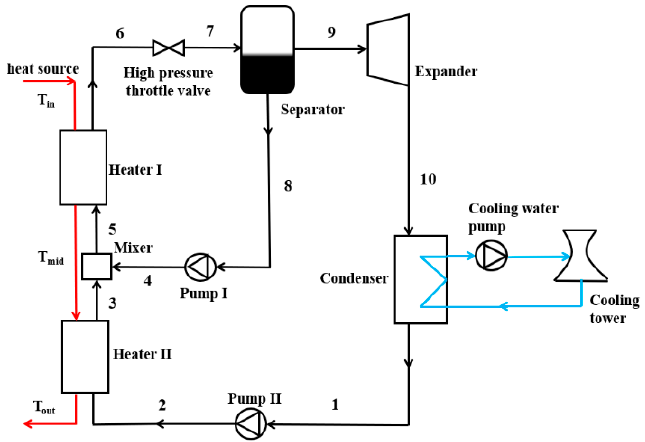
Figure 3. The OFRC system diagram.